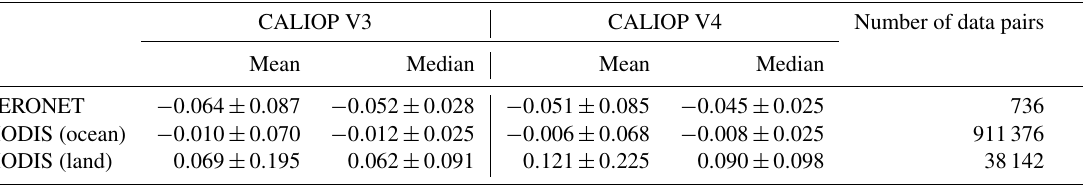
Table 8. Mean ( ± standard deviation) and median ( ± median absolute deviation) of AOD difference between CALIOP and AERONET– MODIS (defined as CALIOP – AERONET–MODIS) for V3 and V4 from 2007 to 2009.